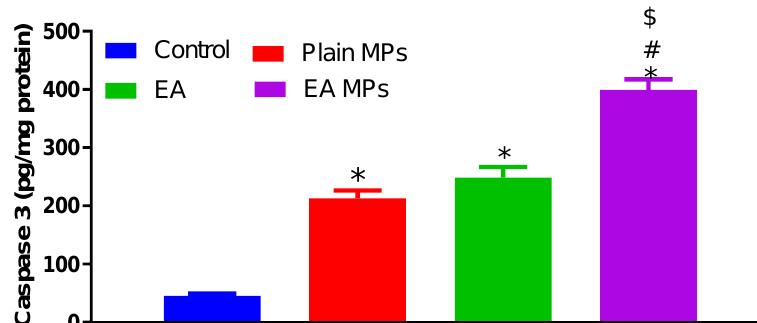
Figure 6. E ff ect of EA formulated in CHIT-ES100 double-coat on caspase 3 content in HCT 116 colon cancer cells. * Significantly di ff erent from control at p < 0.05; # significantly di ff erent from plain MPs at p < 0.05; $ significantly di ff erent EA at p < 0.05.